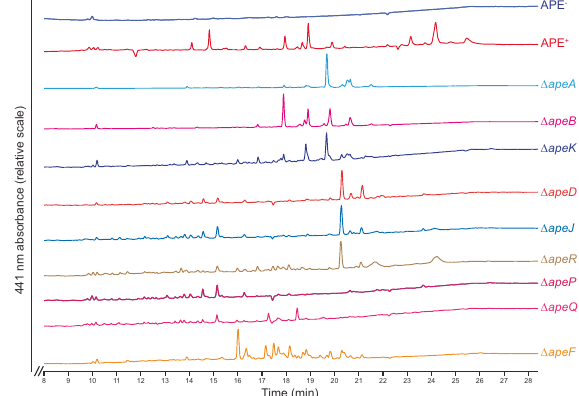
Fig. 4 HPLC traces of E. coli Δ ape strain crude extracts. The APE + extract (red) contained three clusters of APE-related peaks (around 14.5 min (57.5% acetonitrile (ACN)), 19 min (80% ACN), and 24 min (100% ACN)) which are not present in the APE − strain (dark blue). The primary APE lipid eluting at 100% ACN only occurs in the APE + and Δ apeR extracts. The Δ apeA , Δ apeB, and Δ apeK strains produce a comparable set of immature APE carboxylic acids (early intermedi- ates prior to initiation of the attachment process). Δ apeD , Δ apeJ, and Δ apeR produce late pathway intermediates, which likely consist of APE carboxylic acids that are impaired in their proper attachment to the fi nal outer membrane lipid. Deletion of the apeF ACP (orange) results in the formation of a series of yellow-pigmented inter- mediates, indicating it is not strictly required for the biosynthesis of the APE carboxylic acid moiety. HPLC traces for all Δ ape strains that did not have signi fi cant 441 nm absorbance are shown in Fig. S3. HPLC conditions used a gradient of ACN in 0.1% tri fl uoroacetic acid (TFA) water, initiating with a hold at 100% water for 3 min, followed by a gradual increase from 0% to 100% ACN between 3 mi and 23 min, and ending in a 100% ACN hold. Detection was at λ = 441